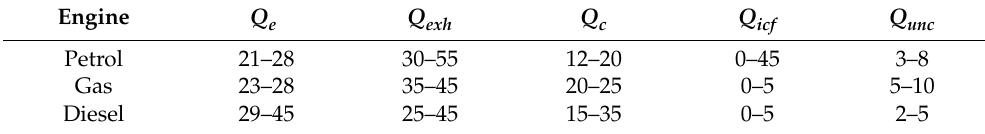
Table 2. Approximate heat balance of internal combustion engines (%)